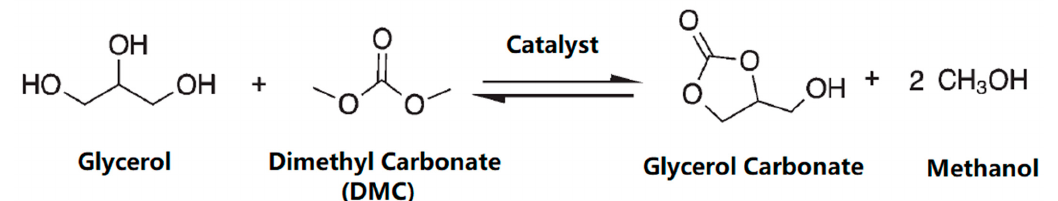
Figure 5. Reaction mechanism between glycerol and dimethyl carbonate for glycerol carbonate production [37].